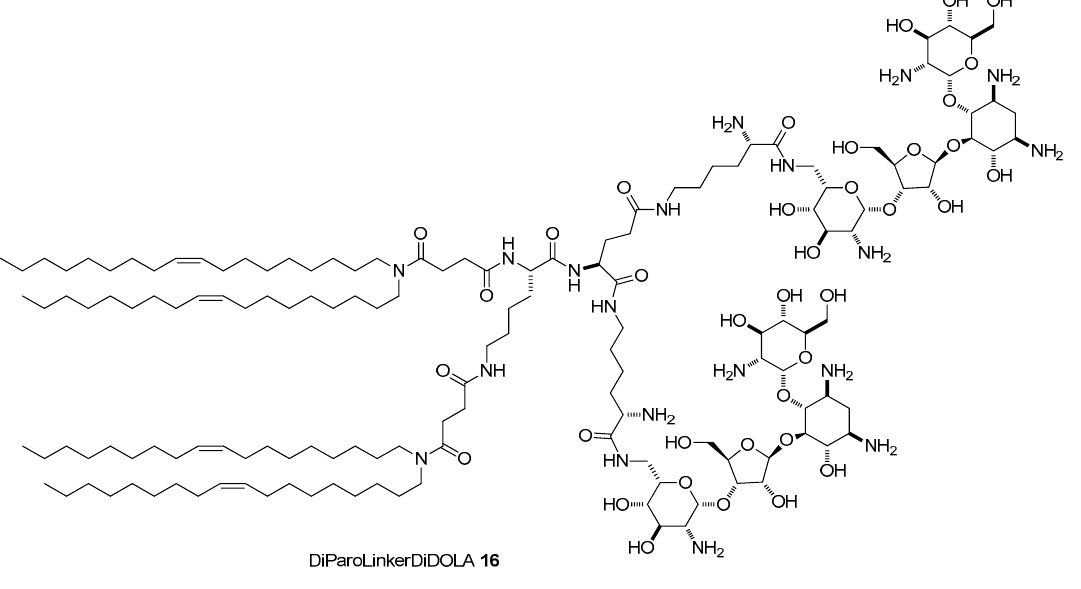
Figure 6. Synthesis of neomycin-based lipids 14 , 15 : (i) Boc 2 O, TEA, DMF/H 2 O, (ii) TIBS-Cl, pyridine,